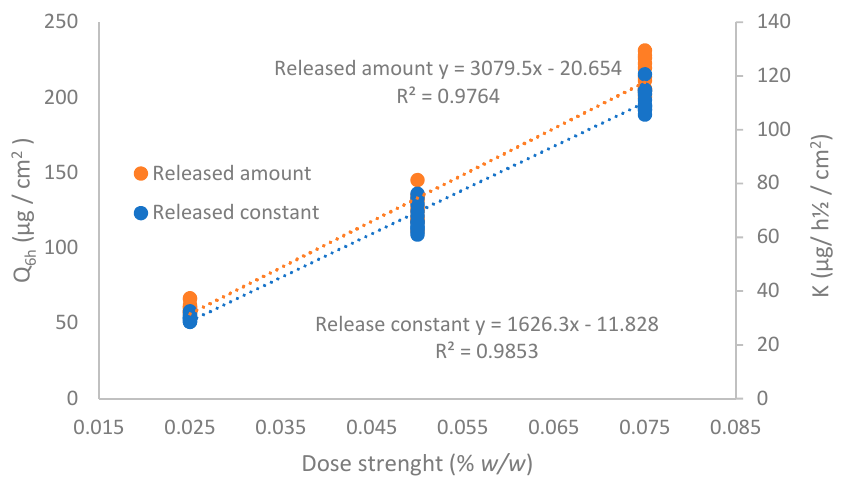
Figure 7. Linearity of the IVRT method for the released amount of capsaicin at 6 h (Q 6h ) and release constant (K).